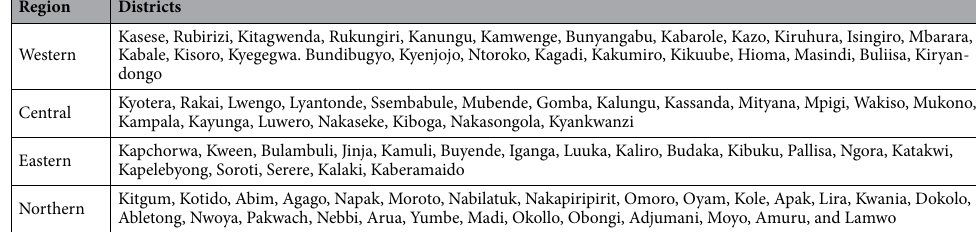
Table 3. Districts across Uganda with moderate to high B. anthracis suitability by